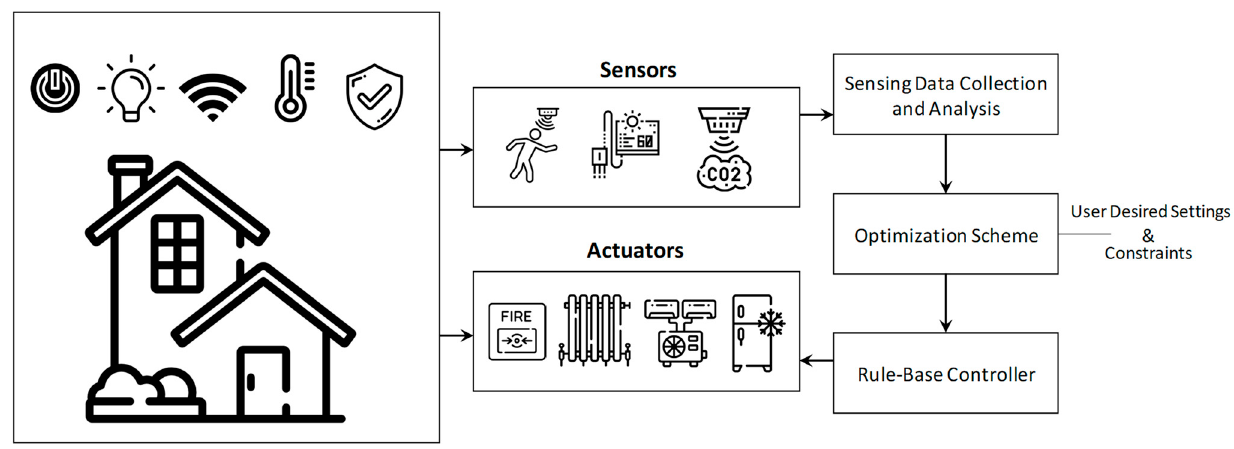
Figure 5. Model of optimization mechanism to achieve energy efficiency in a smart building [58].